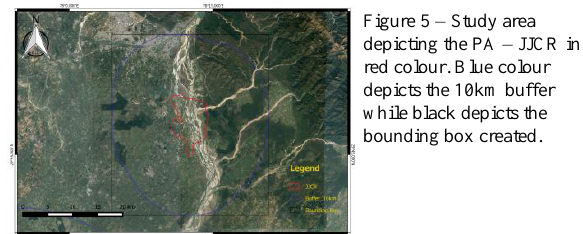
Figure 4– Flowchart depicting the methodology for study